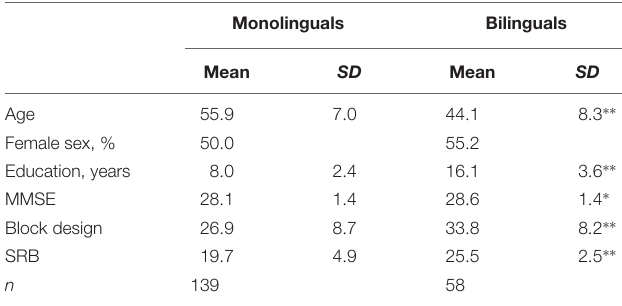
TABLE 1 | Baseline characteristics of monolingual and bilingual participants,